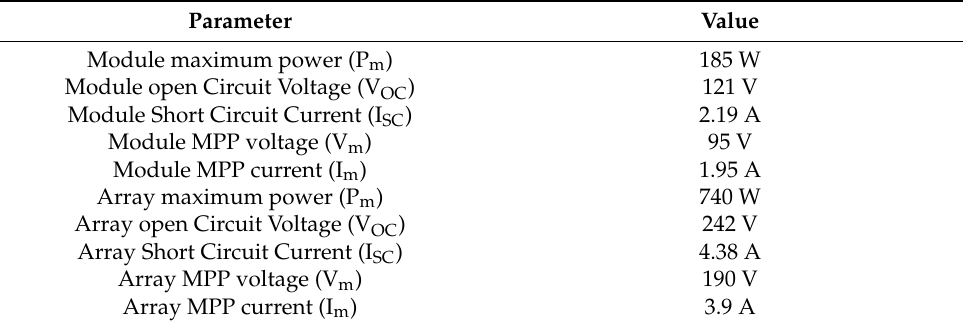
Table 2. PV Array Specifications (SFK185-S).